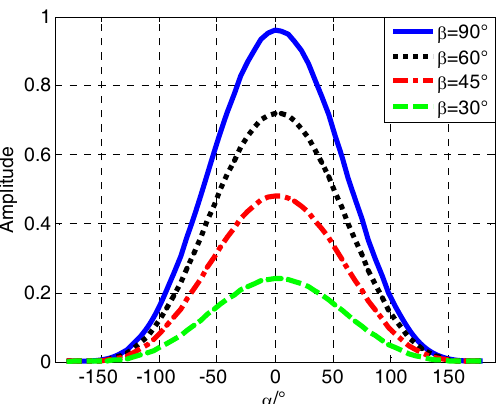
Figure 3. The variation map of signal amplitude received by a rotating antenna.